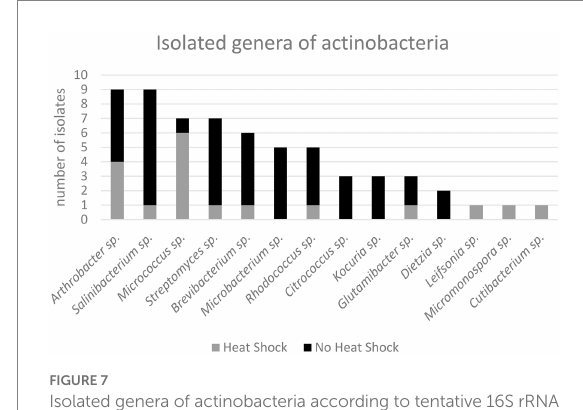
FIGURE 7 Isolated genera of actinobacteria according to tentative 16S rRNA sequencing and phylogenetic